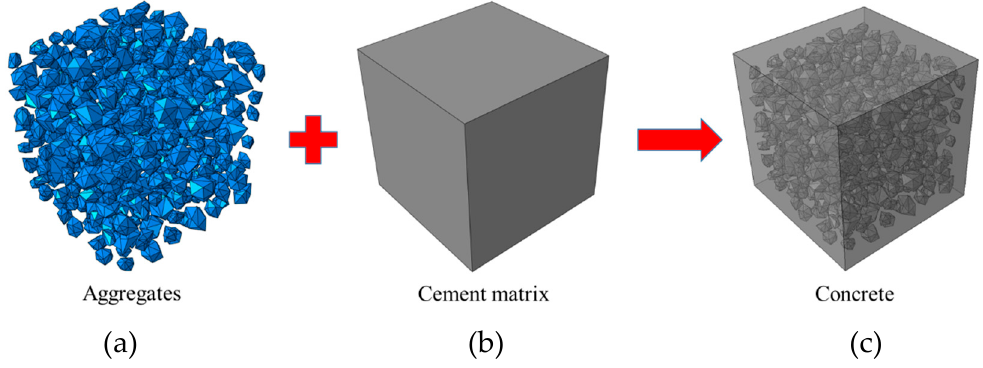
Figure 3. Generation of the two-phase mesostructure of concrete: ( a ) aggregates, ( b ) cement matrix,